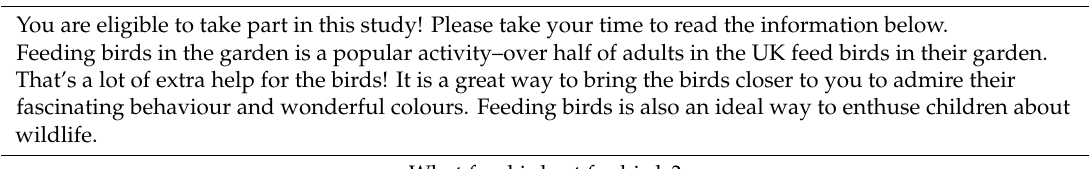
Table A3. Experimental group C: Control group. The Content for This Condition was Drawn from The Royal Society for the Protection of Birds [54].